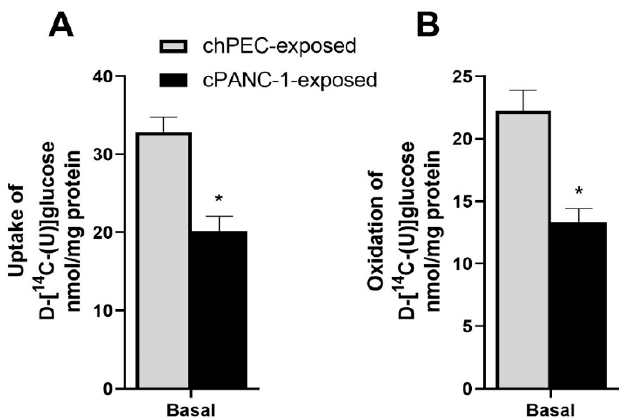
Figure 3. Impact of conditioning myotubes with medium from hPECs or PANC-1 cells on glucose metabolism. In the last 4 days of differentiation, myotubes were conditioned with the medium from human pancreatic epithelial cells (chPEC exposed) or a human pancreatic cancer cell line (cPANC-1 exposed). Thereafter, myotubes were incubated with 200 µ mol/L of D-[ 14 C(U)]glucose (18.5 kBq/mL) for 4 h before glucose uptake and oxidation were measured. ( A ) Uptake was calculated as captured CO 2 + cell-associated (CA) [ 14 C] glucose. ( B ) Complete oxidation was measured as trapped CO 2 . Data are presented as the mean ± SEM from three individual experiments, each with eight replicates ( n = 24). * Statistically significant in cPANC-1-exposed myotubes versus chPEC- exposed cells ( p ≤ 0.05, unpaired t